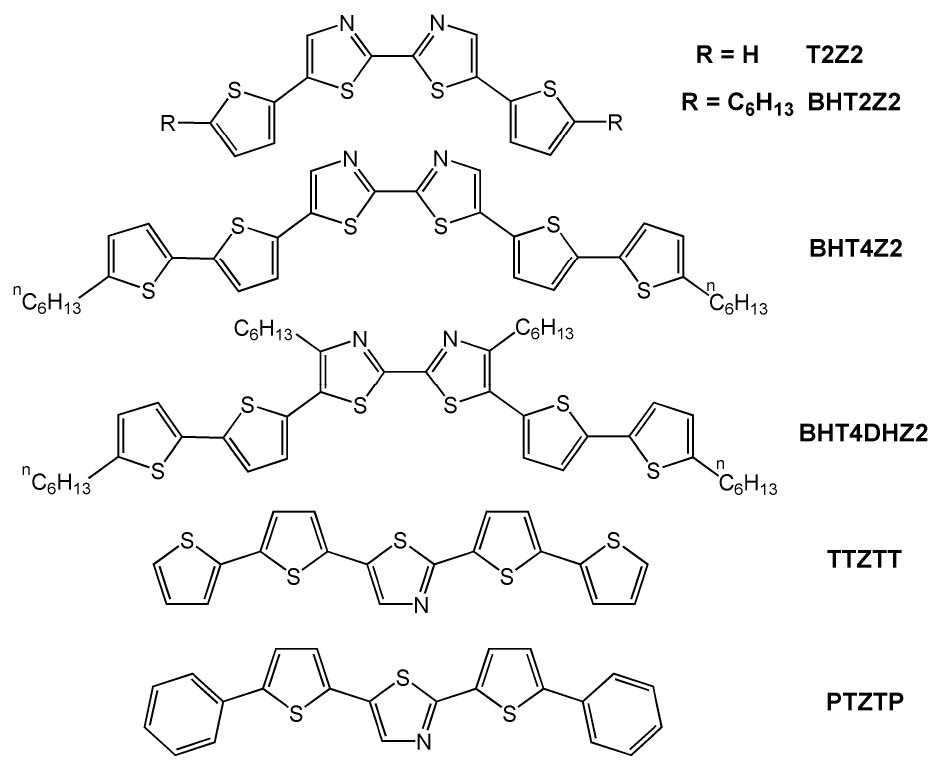
Figure 2. Chemical structures of thiazole-containing